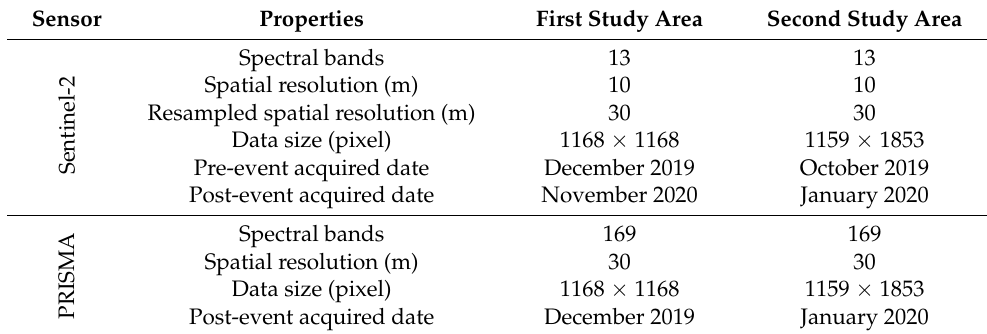
Figure 5. Illustration of the various incorporated datasets for the burned area mapping for the second study area. ( a ) Pre- event Sentinel-2 imagery. ( b ) Post-event Sentinel-2 dataset. ( c ) Post-event PRISMA hyperspectral imagery. ( d ) Ground truth. Table 1. The main characteristics of the incorporated datasets for both case studies.